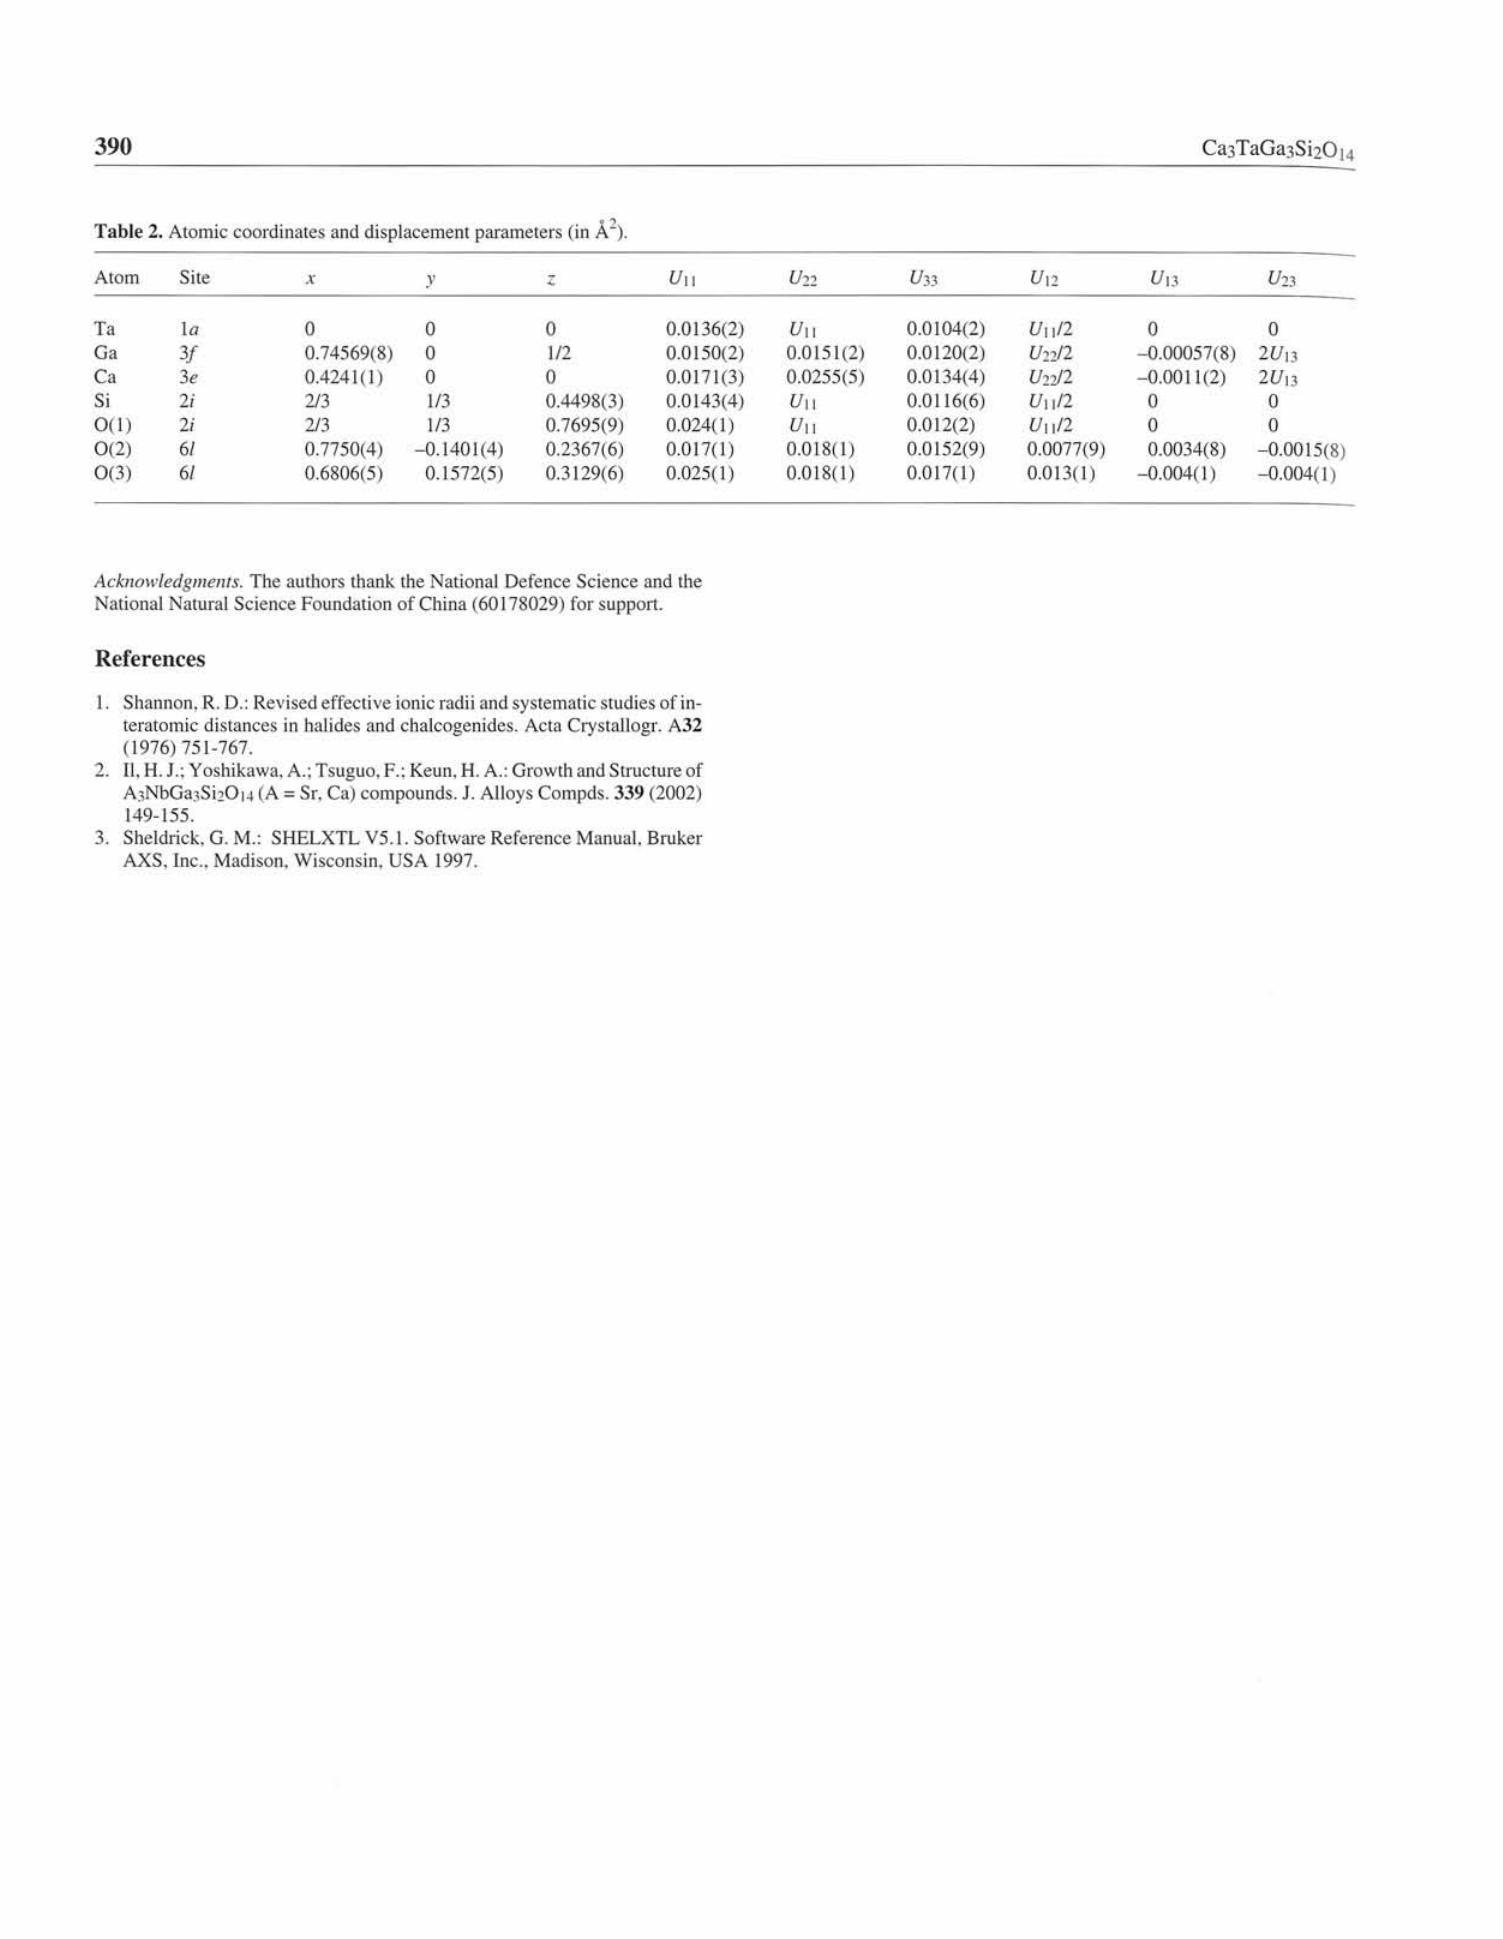
Table 2. Atomic coordinates and displacement parameters (in A 2